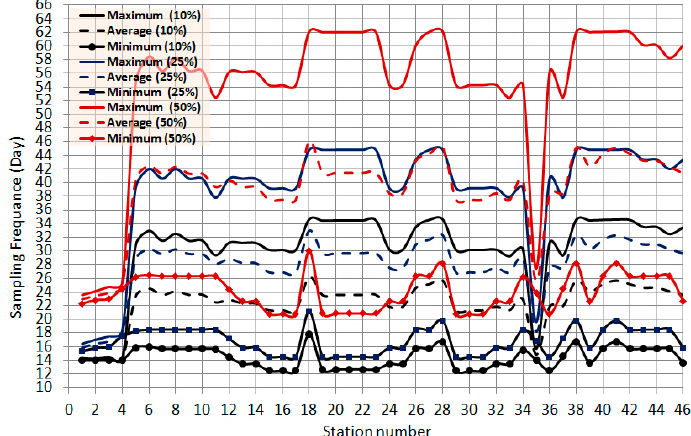
Figure 9. Minimum, average and maximum interval of sampling frequency (SF) of the 46 monitoring stations (MSs), with monitoring accuracies (MA) of ±10%, ±25%, and ±50%.